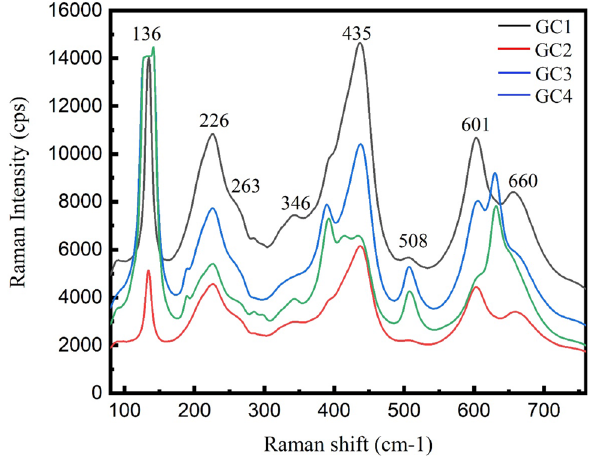
Fig. 7 Raman spectra of LTO prepared from the calcination of gela- tin-chitosan aqua-gel at 750